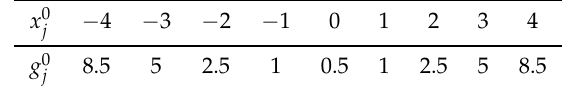
Table 5. Convex data set of values.